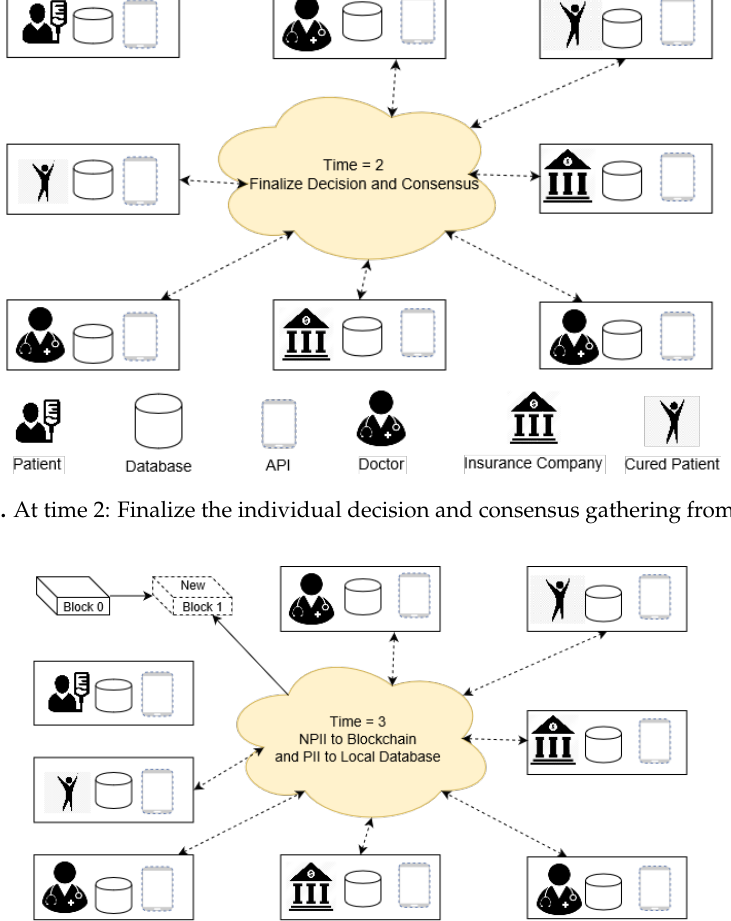
Figure 9. At time 1: Individual decision returns to PoF.